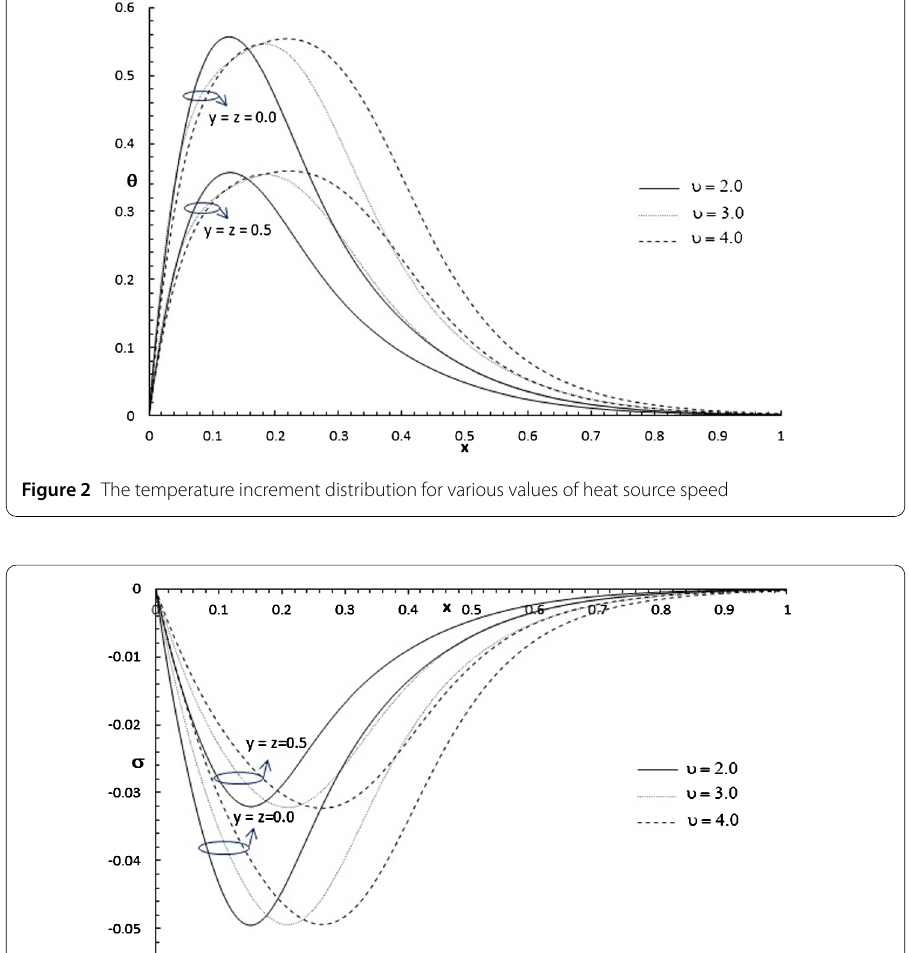
Figures 2–5 represent the temperature increment, stress, strain, and displacement component u x distributions, respectively, for various values of heat source speed υ = (2.0,3.0,4.0) and a wide range of distance x (0 ≤ x ≤ 1) when y = z = 0.0 and y = z = 0.5 to show the effect of the heat source speed on all the studied functions. The value of speed of the heat source has significant effects on all the studied functions. Increasing the values of the speed of the heat source leads to decreasing the temperature increment values and the absolute values of the stress before the peaks, while after the peaks, the increase of the speed of the heat source leads to increases in them. Increasing the values of the speed of the heat source leads to decreasing of the strain and the dis- placement values. The results and the figures have max or min points because the effect of the heat source is working in the interval x < υ t so the temperature increment increases rapidly, while in the interval x ≥ υ t the heat source disappears, which makes the temper- ature increment decrease rapidly. Accordingly, all the other functions will be affected by this attitude. In other words, the value of the position x = υ t is a critical position